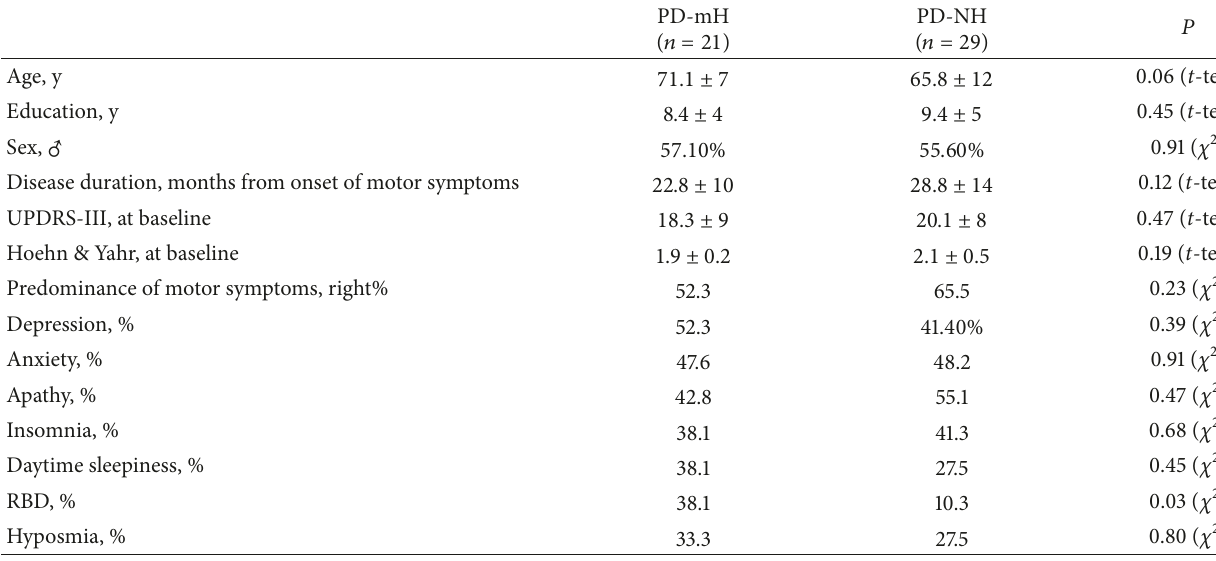
Table 4: Clinical and demographic features of PD patients with and PD patients without hallucinations after following up prospectively.